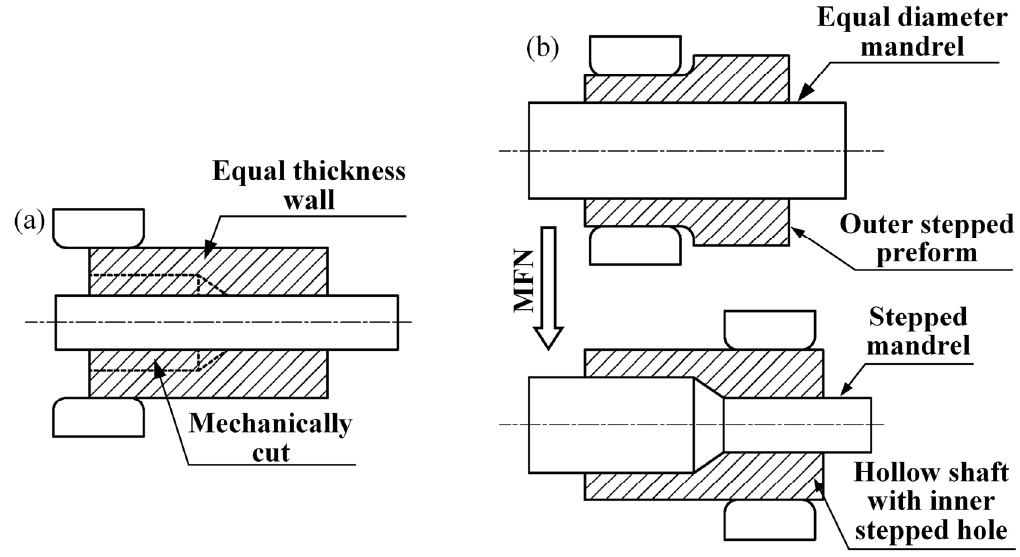
Figure 1. Different processes: ( a ) conventional process; ( b ) mandrel forging and necking (MFN) pro- cess.